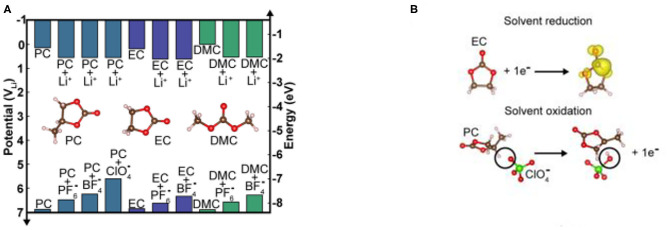
(A) Calculated reduction and oxidation energy levels of common solvents and solvated salts for Li-ion battery. (B) Reaction formulae used for calculating redox levels under ideal conditions (Gauthier et al., 2015) (reproduced from ref. 5 with permission from Springer Nature, copyright 2016).